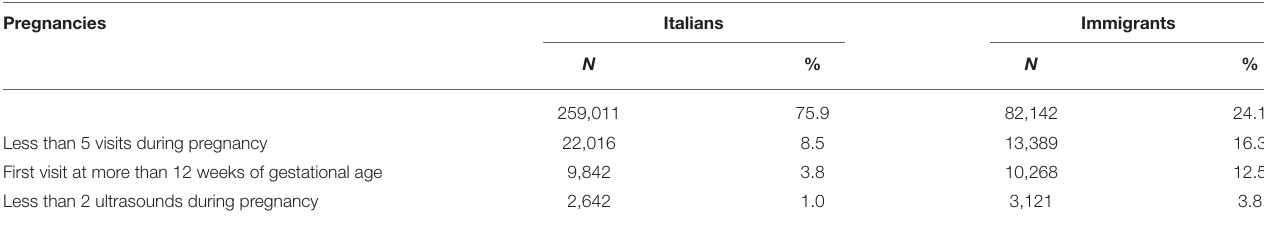
TABLE 1 | Distribution of indicators of maternal health care access by